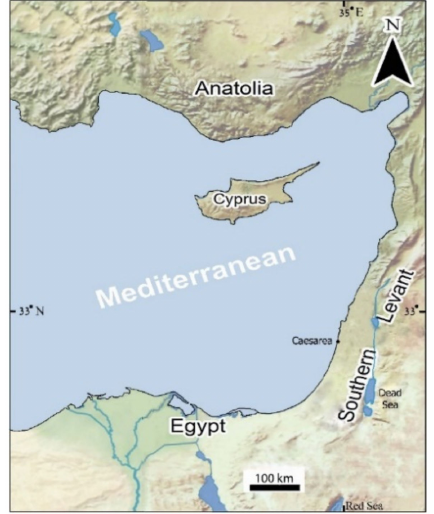
Figure 1. Location of the Caesarea study site. Modified by E. Galili after Natural Earth (www. naturalearthdata.com in the public domain, accessed on 25 March